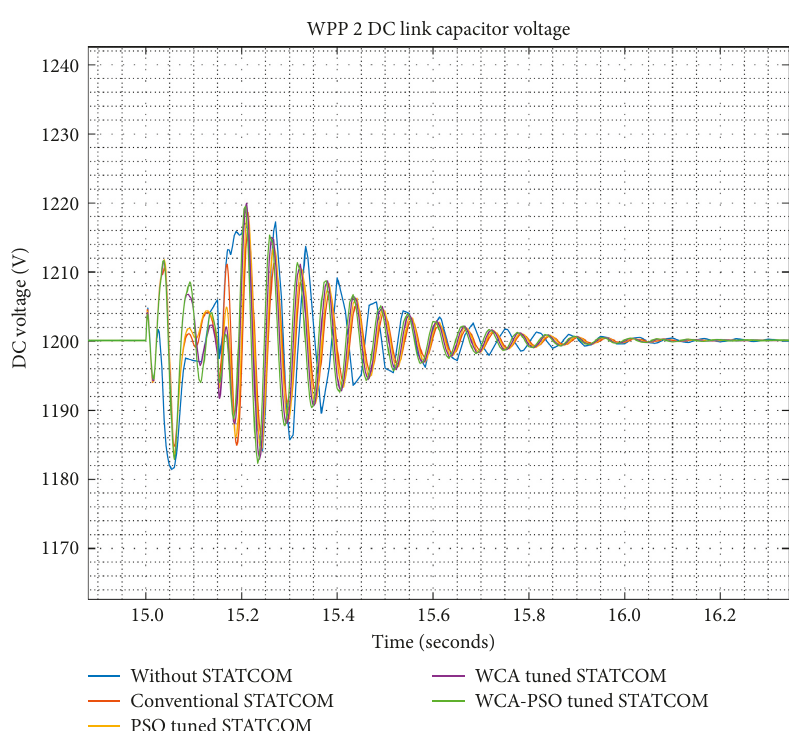
Figure 26: WPP 2 DC link capacitor